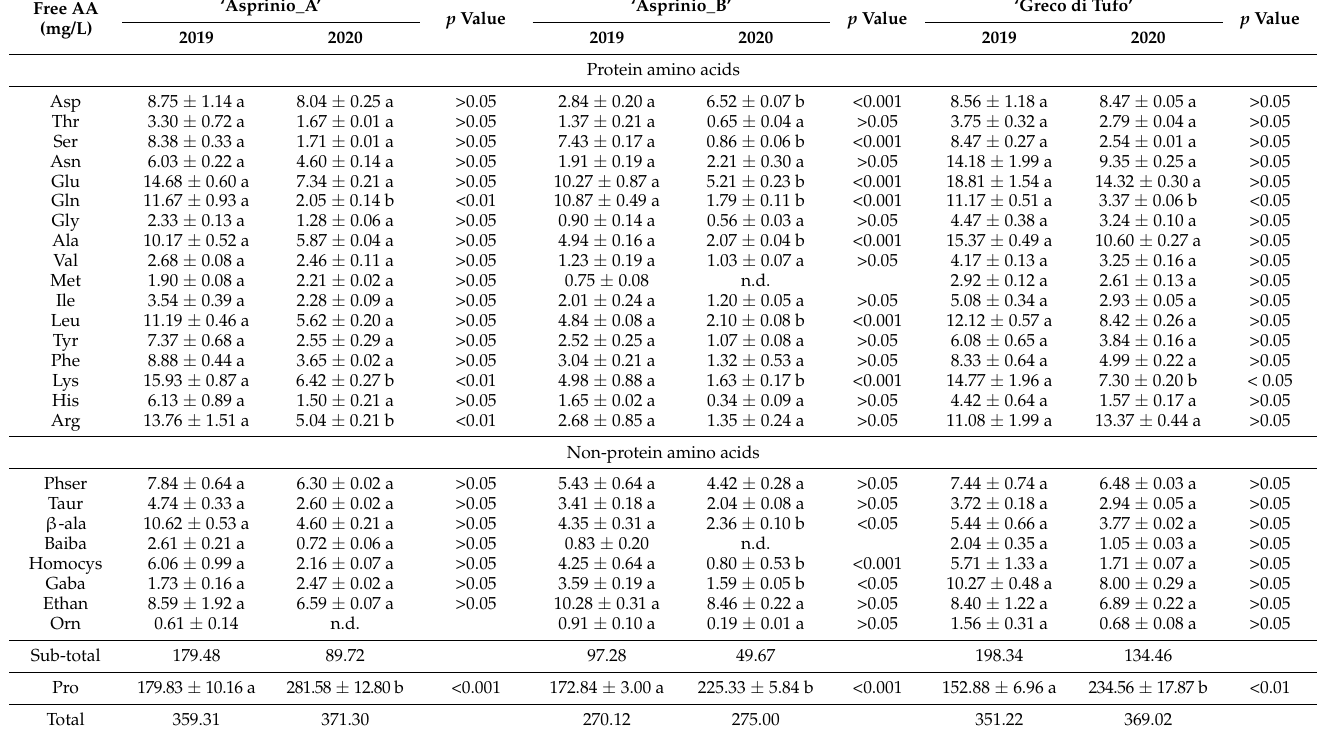
Table 2. Free amino acids composition in ‘Asprinio_A’, ‘Asprinio_B’ and ‘Greco di Tufo’, considering the 2019 and 2020 vintages. Values are means ± SD ( n = 3) and expressed as mg per L of wine. Free AA p Value (mg/L)